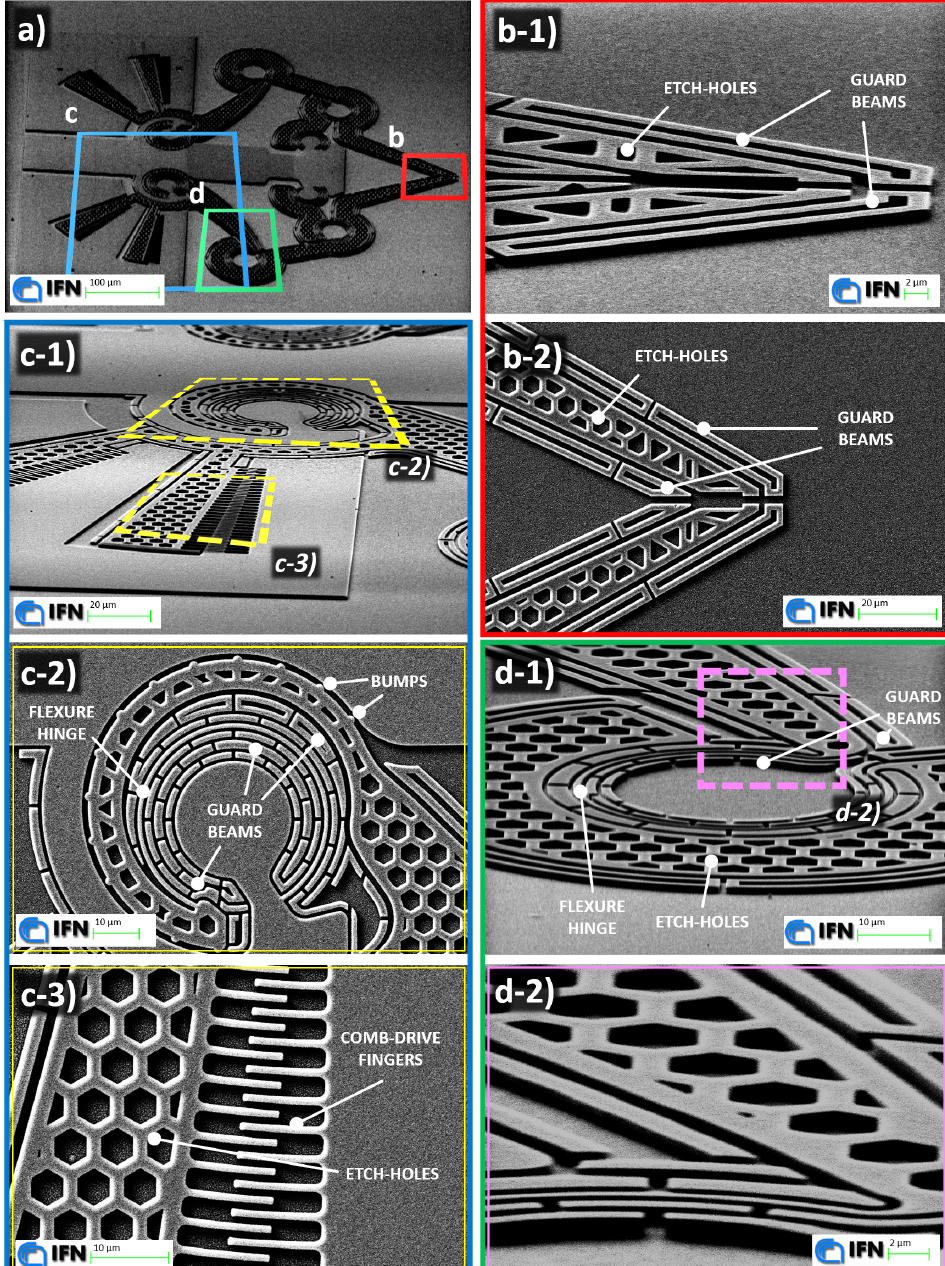
Figure 10. SEM pictures of the fabricated device. ( a ) 30 ◦ tilted and 470 × magnified picture of the whole device. ( b ) Jaw-tips with the honeycomb patterned etch-holes, surrounded by guard beams for correct patterning: 7.8 K × magnified and 70 ◦ tilted picture ( b-1 ), 2.5 K × magnified picture ( b-2 ). ( c ) A 70 ◦ tilted and 2 K × magnified picture ( c-1 ) of a portion of the device with two enlargements: a CSFH ( c-2 ) with the anti-stitching bumps and filled with guard beams (5.1 K × magnification); a rotary comb drive ( c-3 ) with 800nm-wide fingers (5 K × magnification). ( d ) 70 ◦ tilted and 4.65 K × magnified picture ( d-1 ) of a flexure hinge protected by a honeycomb patterned rigid elongation of the four-bar linkage’s coupler and surrounded by guard beams, with an enlargement ( d-2 ) on the hexagonal pattern and guard beams (70 ◦ tilt and 13 K ×